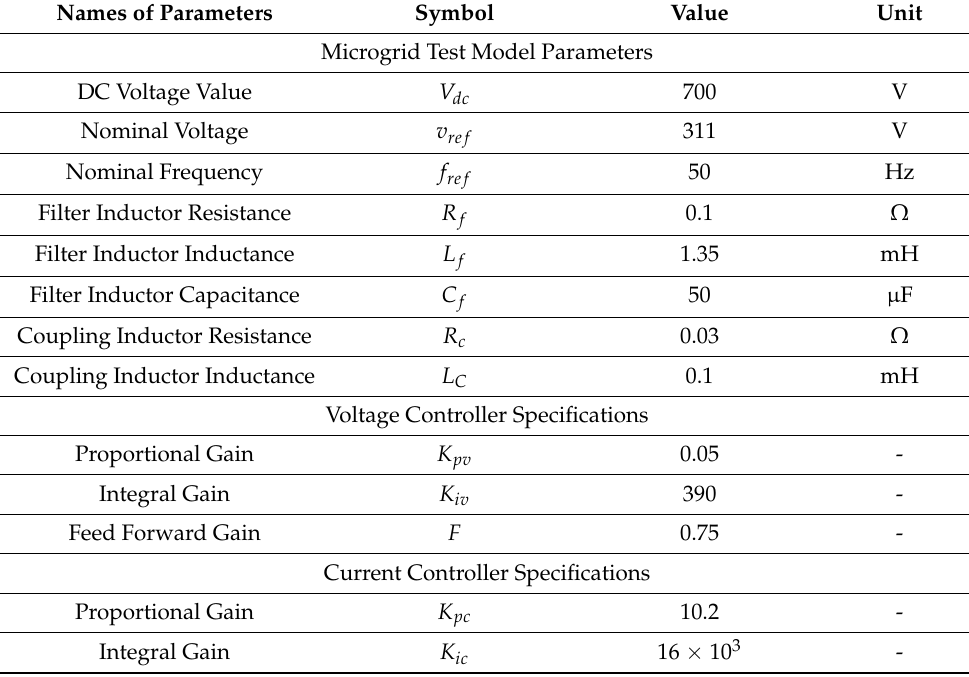
Table A2. Specifications for test